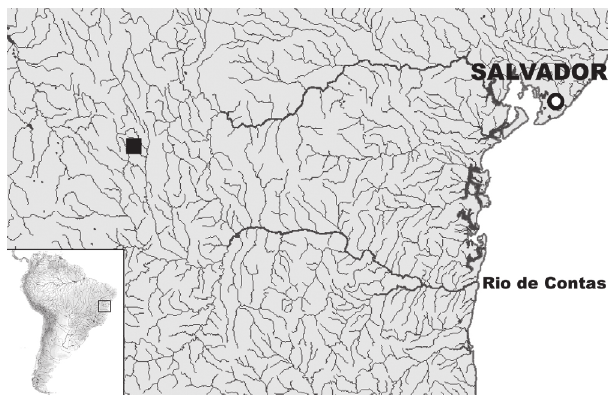
Fig. 4. Rio de Contas basin, Bahia, northeastern Brazil, showing collection locality of Hasemania piatan (square = two close